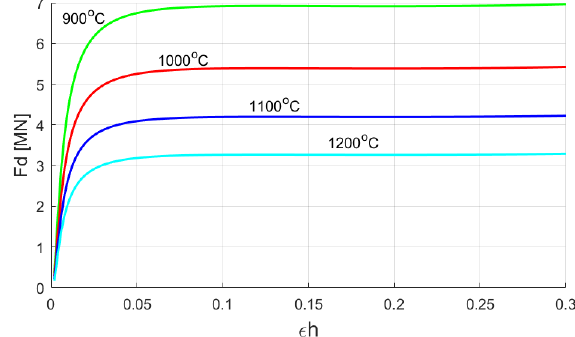
Figure 6: Curves of the predicted forging/deformation force F d as a function of the unit draft ε for different deformation temperatures T h